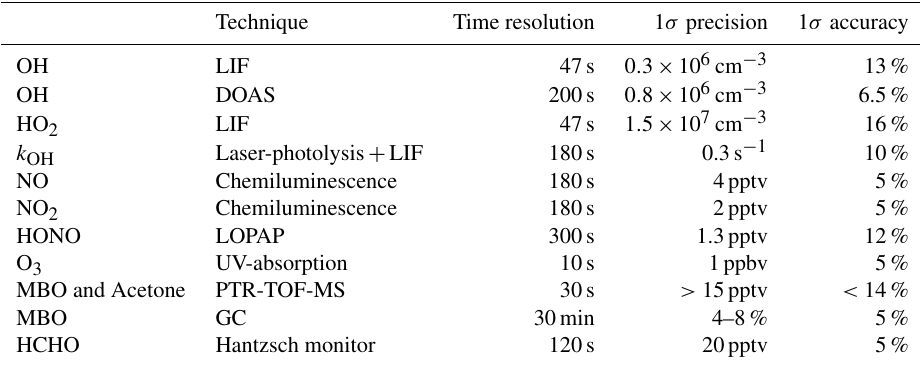
Table 1. Instrumentation for radical and trace-gas quantification during the MBO oxidation experiment.